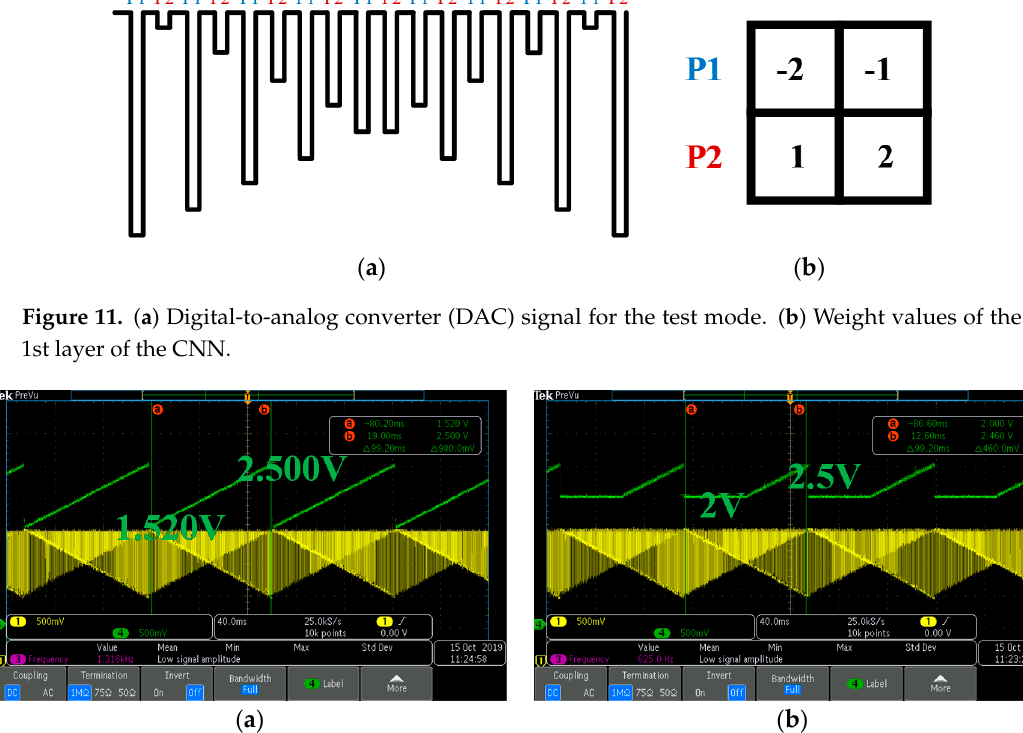
Figure 12. Measurement results in ( a ) the convolution circuit and ( b ) the MAX circuit.